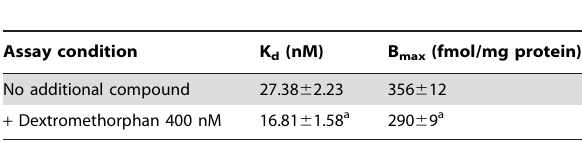
Table 1. Binding parameters for s 1 receptors in the absence and presence of